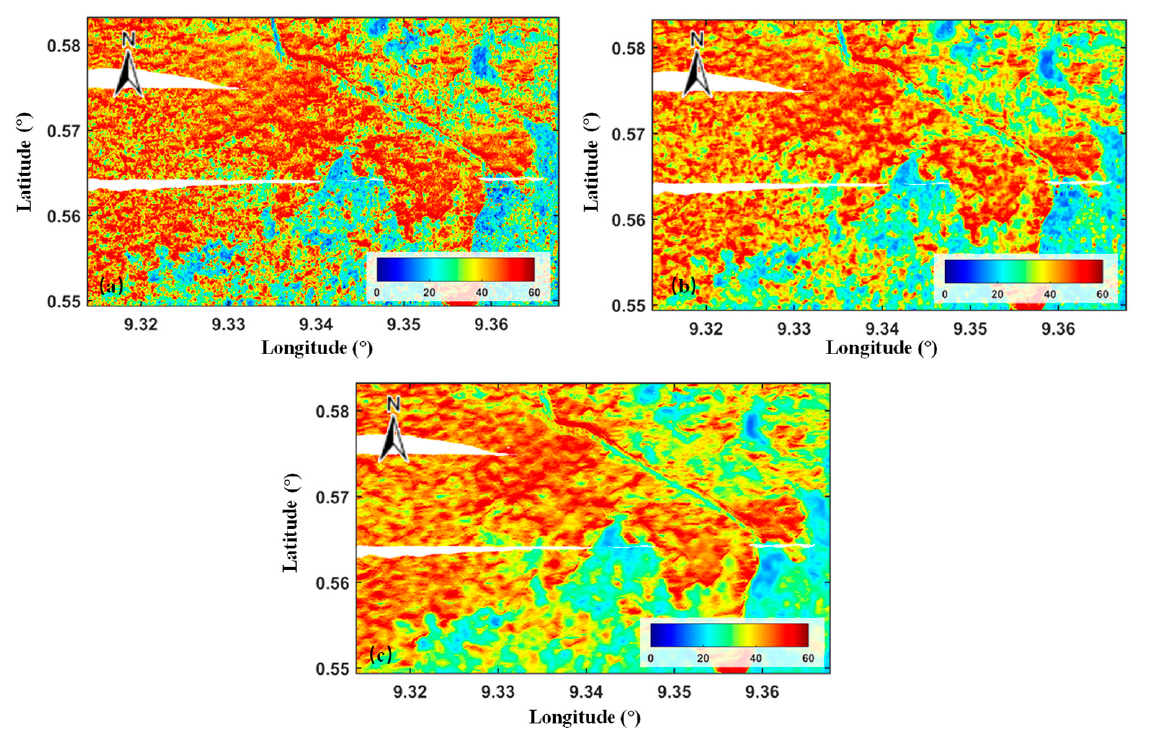
Figure 11. Forest height inversion results for the three sizes in Mondah: ( a ) 5 × 5 size; ( b ) 11 × 11 size; ( c ) 25 × 25 size.